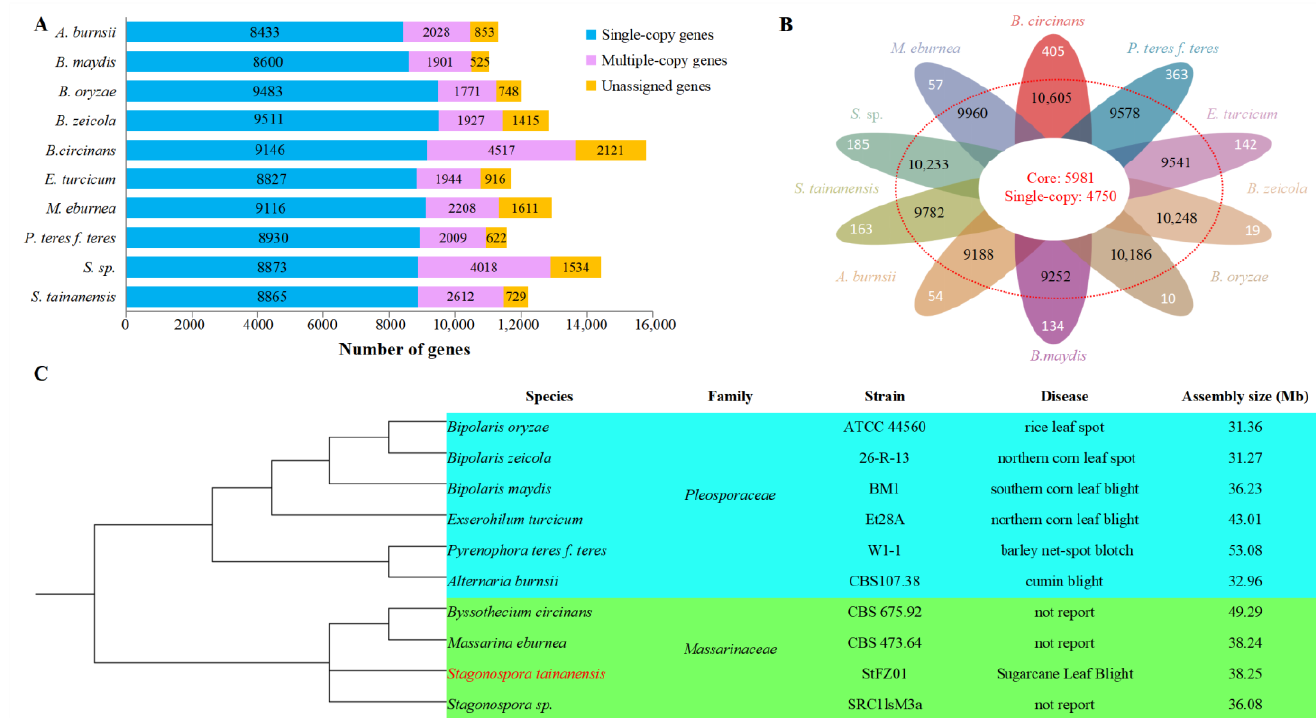
Figure 8. Comparative genomics analysis with close species. ( A ) Genes clustered in orthogroups. ( B ) Summary of orthogroups among species. Species specific genes (white), total orthogroups (black, in the red dotted circle), and core orthogroups (red) were shown from outside to inside of flower. ( C ) Phylogenetic tree inferred with alignment of single-copy core orthogroups.